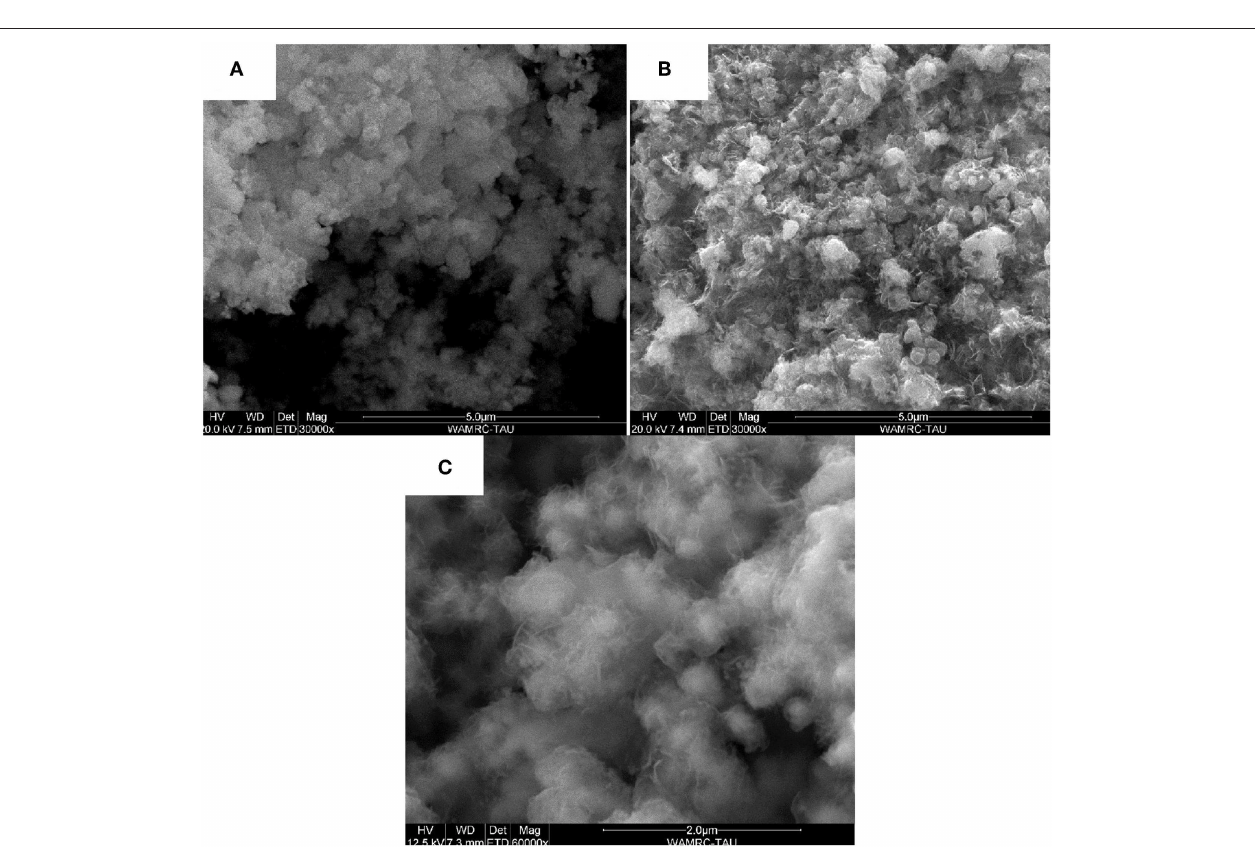
FIGURE 5 | SEM images of the synthesized Ni x Co y O z _20:80 powders (A) before annealing (B) after annealing at 445 ◦ C (C) after annealing at 300 ◦ C.